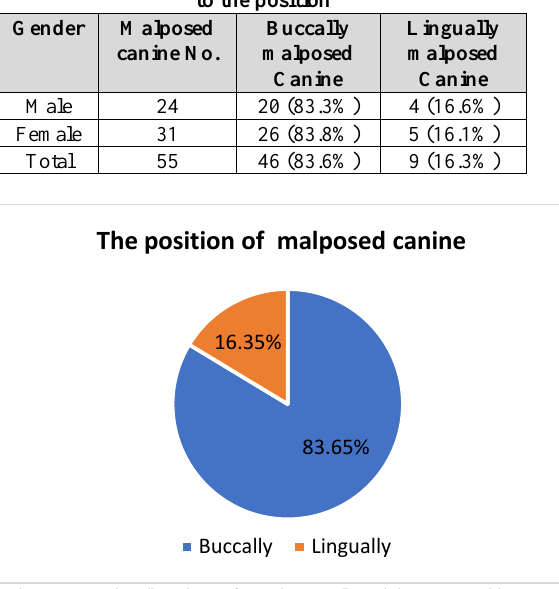
Figure 2: Distribution of canine malposition according to the position